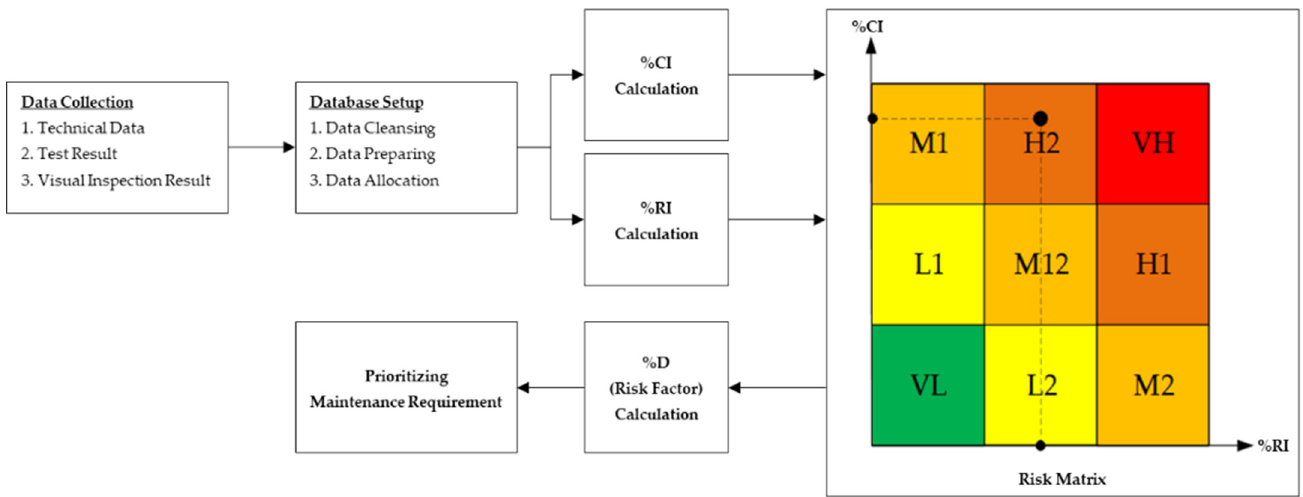
Figure 1. The overview diagram of the proposed method.